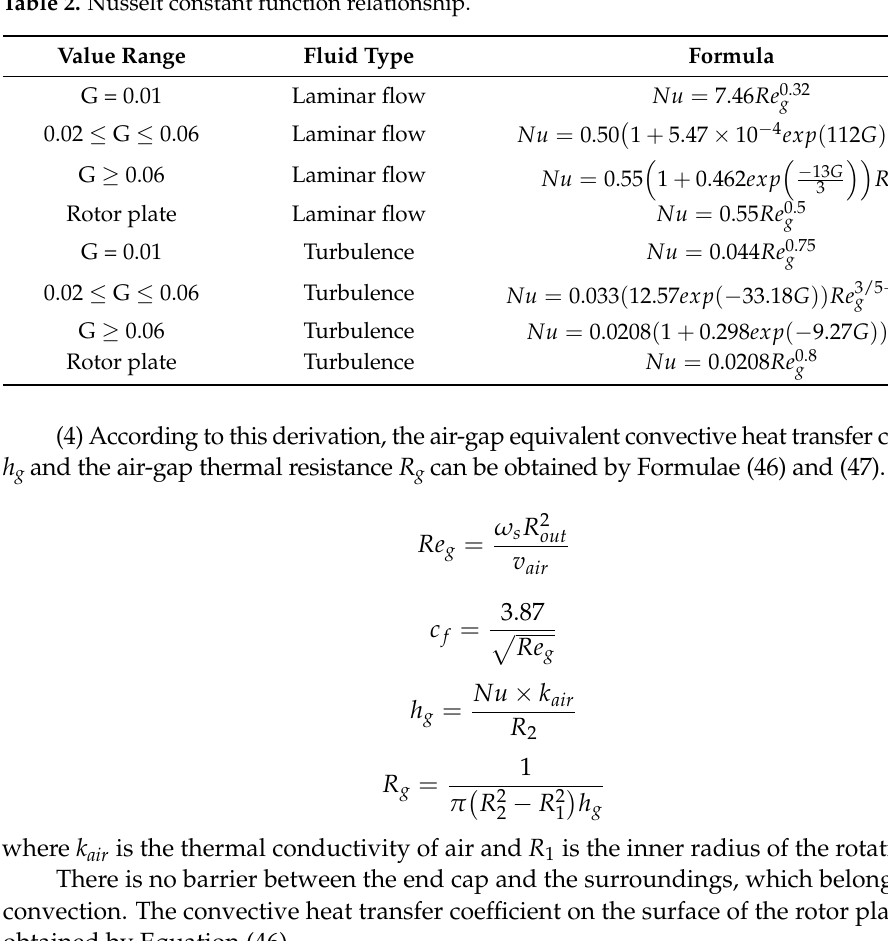
Table 2. Nusselt constant function